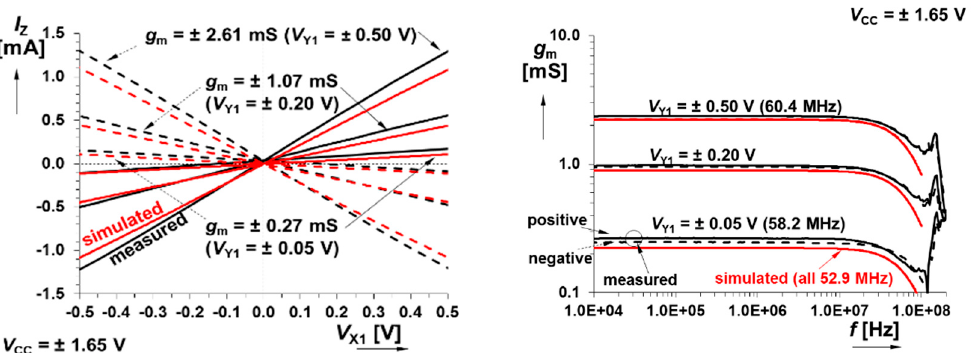
Figure 8. Selected results of the measured and simulated responses of the BJT MLT: (left) DC transfer responses X 1 → Z for a V Y1 controlled by DC voltage; (right) magnitude of AC transfer responses X 1 → Z for a V Y1 controlled by DC voltage.